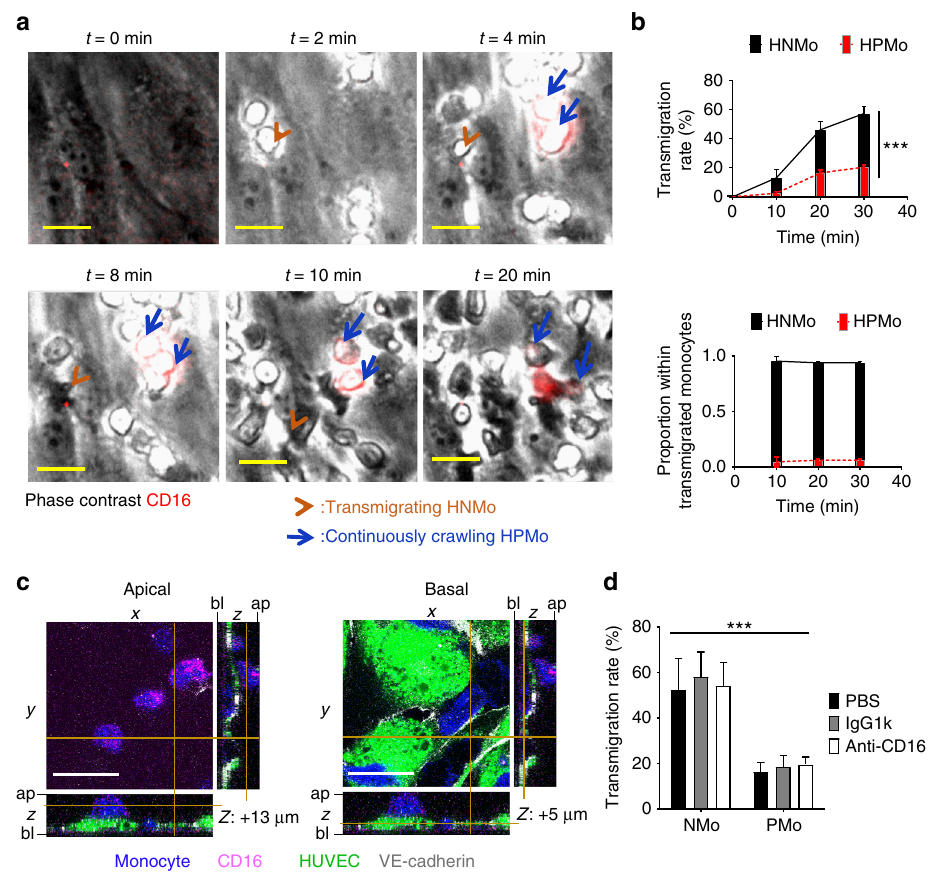
Fig. 3 Angiogenic monocytes present low transmigration in conventional in fl ammatory conditions. a Prongiogenic (non-classical and intermediate CD16+) versus non-angiogenic (in fl ammatory CD16-) monocyte transmigration through TNF-activated endothelium under fl ow assay by live imaging. Non- angiogenic monocytes transmigrate through TNF-activated endothelial monolayer, whereas angiogenic monocytes adhere but remain crawling with very few transmigrating. Scale bar = 10 µ m, blue arrows indicate crawling proangiogenic monocytes and brown arrowhead shows a transmigrating non- angiogenic monocyte. b Quanti fi cation of the transmigration ef fi ciency of proangiogenic versus non-angiogenic monocytes overtime (top) and the proportion of monocyte subsets within the transmigrated pan-population (bottom) indicating most abluminal monocytes were non-angiogenic under conventional in fl ammatory conditions. n = 3 independent experiments with monocytes from three different donors, the data presented as mean ± s.e.m., *** p -value = 0.0004 in two-way ANOVA test. c Post-transmigration assay analysis of proangiogenic monocyte localisation by confocal microscopy. Scale bar = 10 µ m, orthogonal presentation shows views from x , y and z axes. Basal (bl) and apical (ap) extremities are indicated. HUVEC and monocytes were pre-stained respectively with green and blue cell tracker, and proangiogenic monocytes and cell junctions were stained respectively with anti-CD16 and anti-VE-cadherin after transmigration assays. Orthogonal views show adherent but non-transmigrated proangiogenic monocytes on endothelial luminal surface. d Effect of CD16 labelling on proangiogenic monocytes transmigration analyzed after transmigration assay. n = 4 independent experiments with monocytes from four different donors, 150 individual cells tracked for each condition, the data presented as mean ± s.d., *** p -value < 0.0001 in two-way ANOVA. The monocyte positioning was unaffected by labelling with the CD16 antibody used for tracking proangiogenic